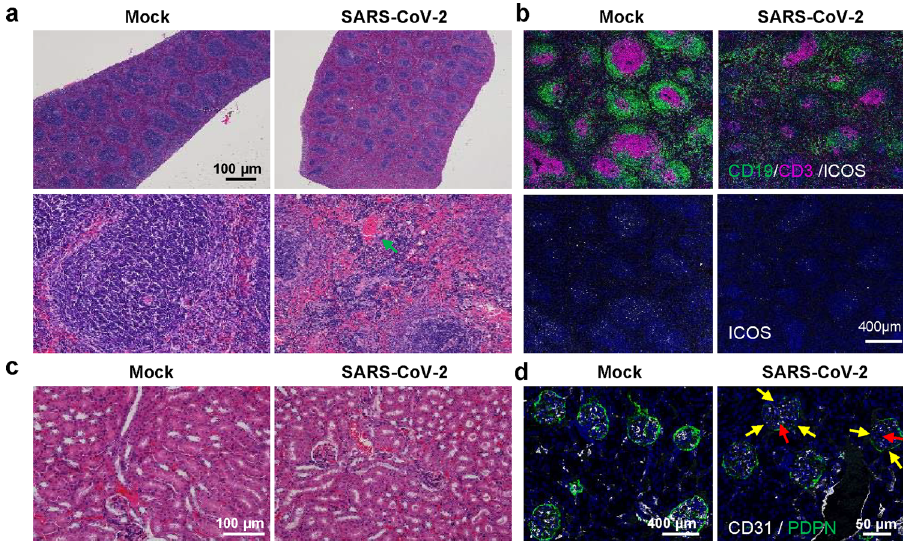
Fig. 4 Spleen and kidney injury during BALB/c mice infection with MASCp36. a H&E staining of spleen sections from male BALB/c mice (9-month-old) infected with MASCp36 ( n = 3 per group). b Multiplex immuno fl uorescence staining of mouse spleen sections for detection of CD19 (green) B cells, CD3 (magenta) T cells, and ICOS (white) follicular helper T cells ( n = 3 per group). c H&E staining of kidney sections from male BALB/c mice (9-month-old) infected with MASCp36 at 4 dpi ( n = 3 per group). d Multiplex immuno fl uorescence staining of mouse kidney sections for CD31(white) and PDPN (green) ( n = 3 per group). The yellow and red arrows indicate discrete glomerular basement membrane and endothelial vessels,